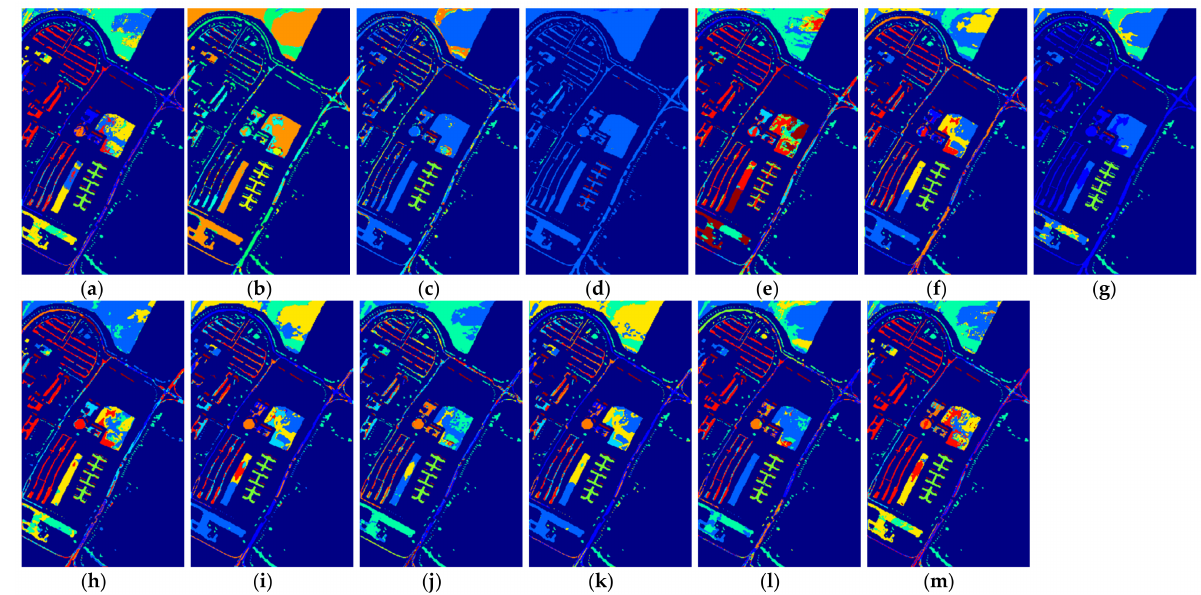
Figure 13. The classification maps of all methods with one sample on PaviaU dataset. ( a ) SVM; ( b ) SS-LapSVM; ( c ) 3D-DENSEnet; ( d ) 3D-Gan; ( e ) SS-CNN; ( f ) 3D-CNN; ( g ) 3D-CNN k - means ( h ) 3D-CNN ours ; ( i ) 3D-CNN hardlabel ; ( j ) SSRN; ( k ) SSRN k - means ; ( l ) SSRN ours ; ( m ) SSRN hardlabel .